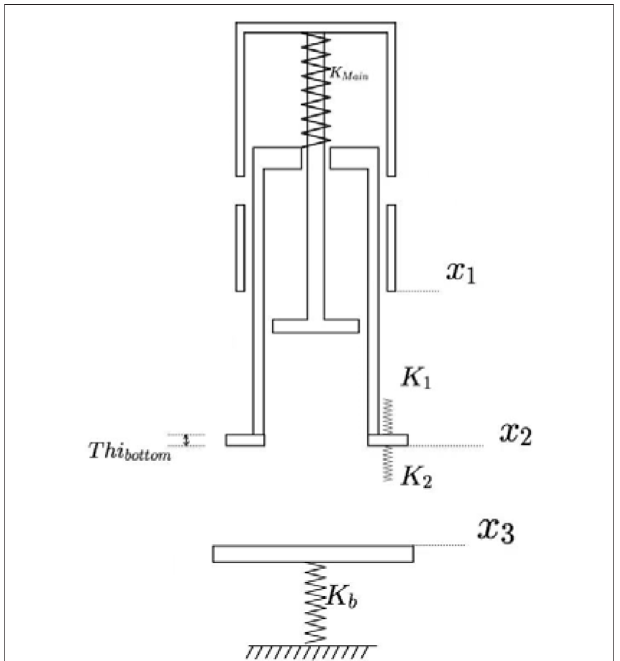
FIGURE 2 | Mechanical simpli fi ed model of buffer